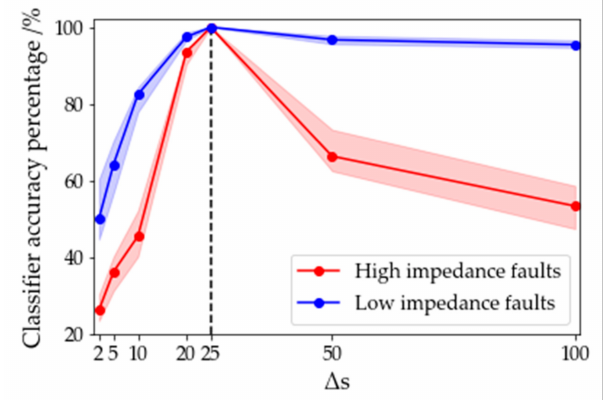
Figure 15. Test results when the number of categories